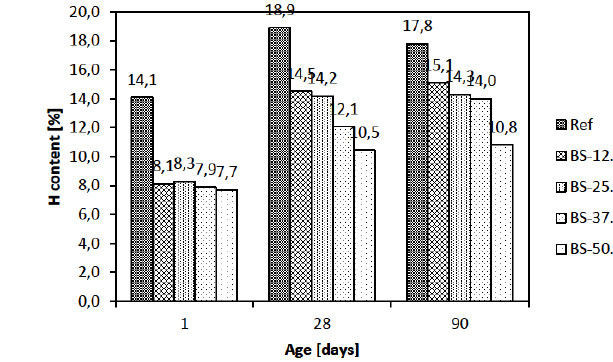
Figure 4: Development of Ca(OH) 2 in pastes with fly ash addition in time.